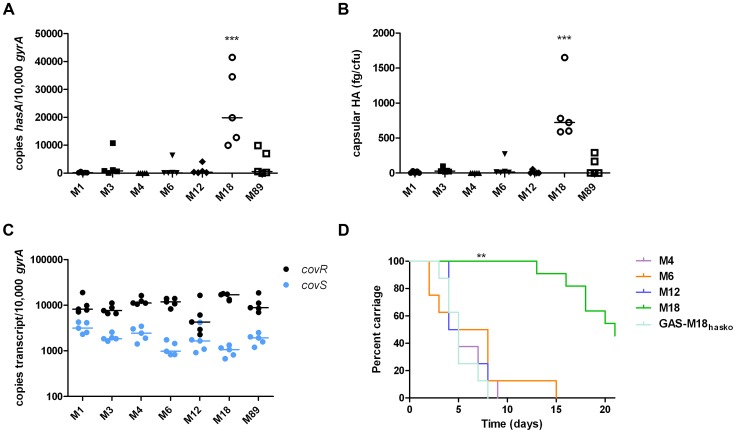
Serotype M18 GAS display a unique hyper-encapsulation phenotype which mediates enhanced nasopharyngeal carriage longevity.Characterization of serotype M18 GAS by comparison with representatives of each of six major serotypes (n = 5 isolates/group). (A) Inter-serotype comparison of absolute copy number for hasA standardized to housekeeping gene gyrA. Line shows median (Kruskal-Wallis; *** = p<0.001). (B) Inter-serotype comparison of capsular HA expression across all serotypes by an ELISA-based assay. Line shows median (Kruskal-Wallis; *** = p<0.001). (C) Inter-serotype comparison of absolute transcript copy number for covR and covS standardized to house-keeping gene gyrA. Line shows median (Kruskal-Wallis; p = NS). (D) Inter-serotype comparison of duration of nasopharyngeal shedding of pharyngitis-associated serotypes M4, M6, M12 and M18 with isogenic capsule disruptant mutant GAS-M18hasko (n = 8 mice/group). Data represent percentage of mice shedding each strain for 21 days following intra-nasal challenge (LogRank; ** = p<0.01).